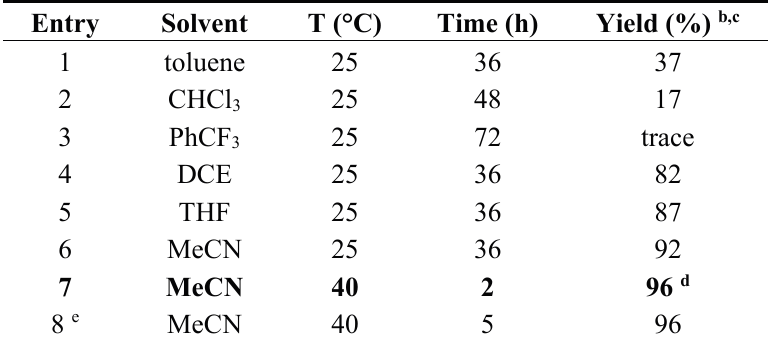
Table 1. Optimization of reaction conditions using MBH carbonate 1a and sodium benzenesulfinate 2a a